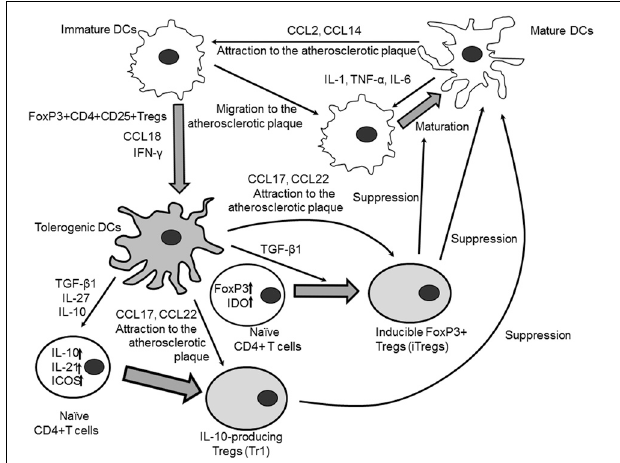
FIGURE 3 | Crosstalk between immature and mature DCs. Mature DCs could attract immature DCs and DC precursors to the site of inflammation (i.e., to the atherosclerotic plaque) through secretion of chemokines CCL2 and CCL14. Immature DCs in turn migrate to the plaque where they are activated by the local proinflammatory microenvironment to differentiate preferentially to inflammatory mature antigen-presenting DCs. Local mature DCs could contribute to the proinflammatory DC maturation by secreting inflammatory cytokines IL-1 β , IL-6, and TNF- α . Natural FoxP3 + CD4 + CD25 + T cells induce conversion of immature DCs to tolerogenic DCs. Chemokine CCL18 produced by immature DCs stimulates tolerogenicity through the induction of IL-10-mediated expression of IDO in DCs. IFN- γ is able to contribute to the formation of tolerogenic DCs by inhibiting expression of Th17-inducing osteoprotegerin and stimulating IL-27 production. IL-27 suppresses production of Th17-polarizing cytokines IL-1 β , IL-6, and IL-23 from DCs and activates expression of IL-10, IL-21, and ICOS in naïve CD4 + T cells that drives induction of IL-10 producing Tregs (Tr1). IL-10 produced by tolerogenic DCs induces Tr1 cells through the ILT2/ILT4-mediated signaling mechanism. TGF- β 1 secreted by tolerogenic DCs could induce expression of FoxP3 and IDO in CD4 + CD25 − naive T cells that promotes their conversion into inducible FoxP3 + Tregs (iTregs). Chemokines CCL17 and CCL22 secreted by tolerogenic CDs attract Tregs to the atherosclerotic lesion where Tregs could suppress immunomodulatory properties of proinflammatory antigen-presenting CDs and prevent differentiation of immature CDs to inflammatory subsets of mature